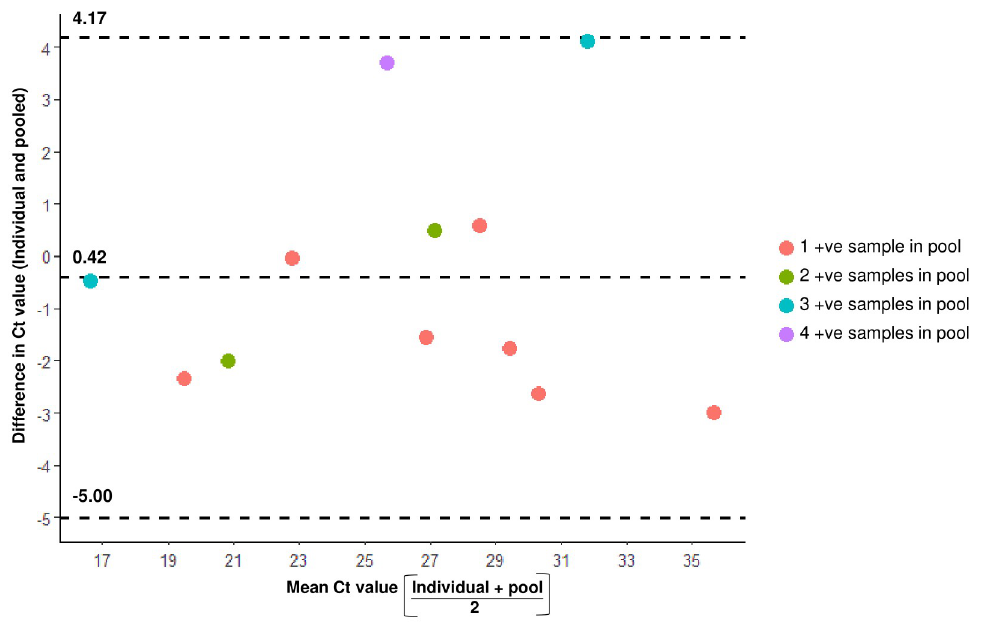
Fig 2. Bland Altman (BA) plot showing the relationship between Ct values of pooled versus individual samples. BA plot was drawn to visualize the relationship between the individual Ct values of sample(s) in a pool with the mean Ct value of the positive sample(s) in the pool. BA lines (dashed lines) assign the mathematical expression of this discrepancy by obtaining the 95% CI of deviation from point estimate (0.42).